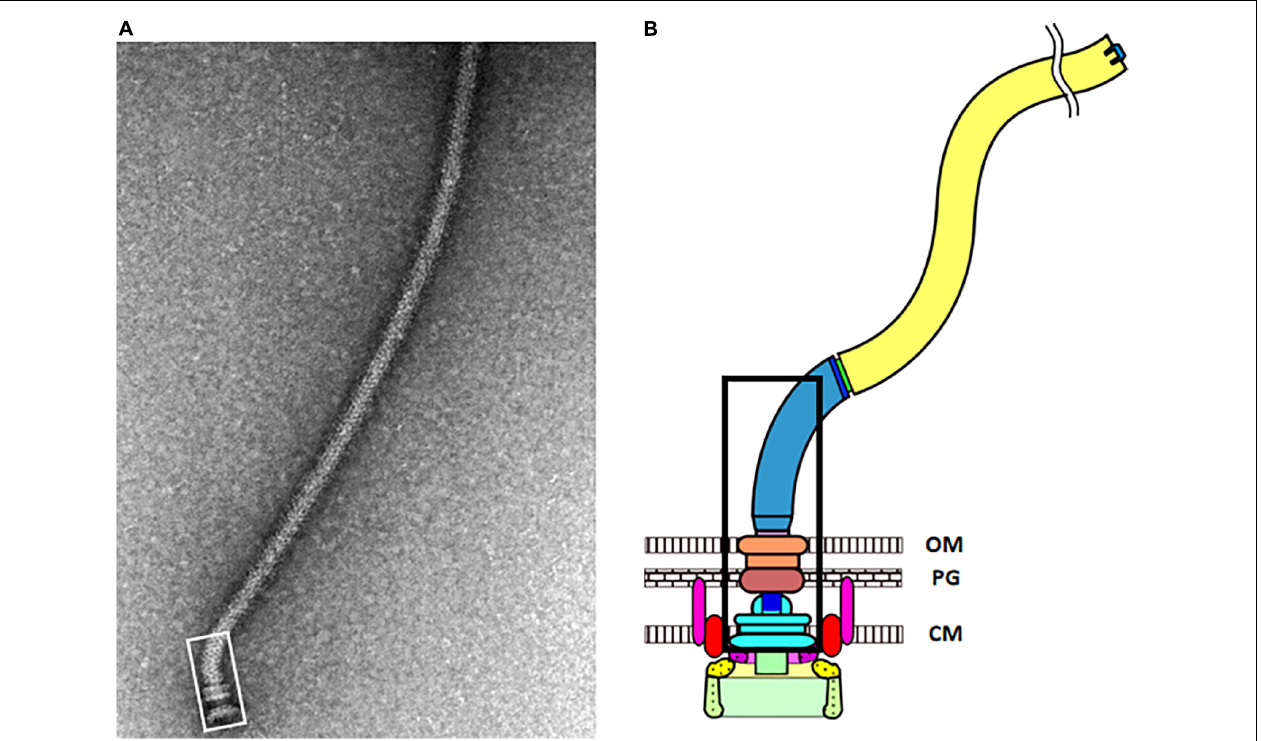
FIGURE 2 | (A) Electron micrograph of an isolated flagellum. The vast majority of the photo shows the long flagellar filament. The hook-basal body complex is outlined by the white rectangle at the lower left. It contains the MS-ring, the rod, the P-ring, the L-ring, and the proximal hook. The C-ring, the export apparatus, and the MotAB stators did not co-isolate with the hook-basal body complex. (B) Cartoon image of an E. coli flagellum. The portion of the hook-basal body outlined by the white rectangle in panel (A) is outlined by the black rectangle. Two MotAB stator units are shown, with MotA in red and MotB in pink. Below the MS-ring (light blue) is the export apparatus show in purple and as a green rectangle. FliG (yellow) is at the top of the C-ring, where it can interact with MotA. FliM and FliN (light green) are below FliG (Images kindly provided by Tohru Minamino, Osaka